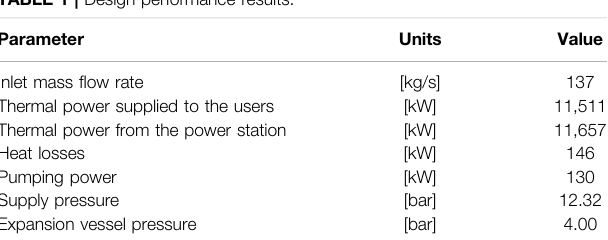
TABLE 1 | Design performance